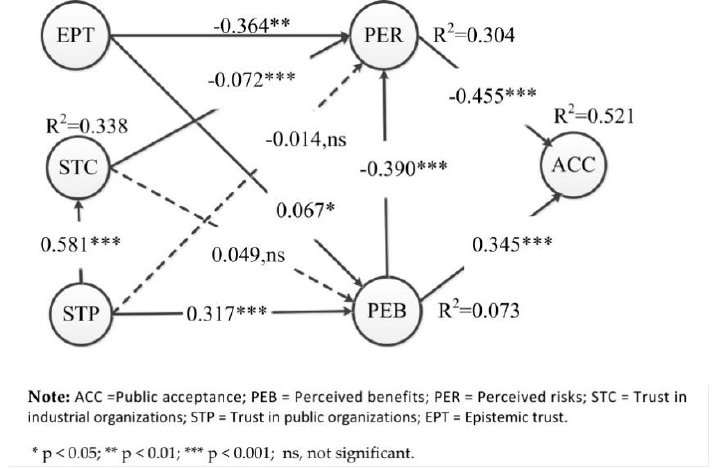
Figure 2. Result of partial least squares (PLS) analysis for structural model. Table 5. Causal relationships .